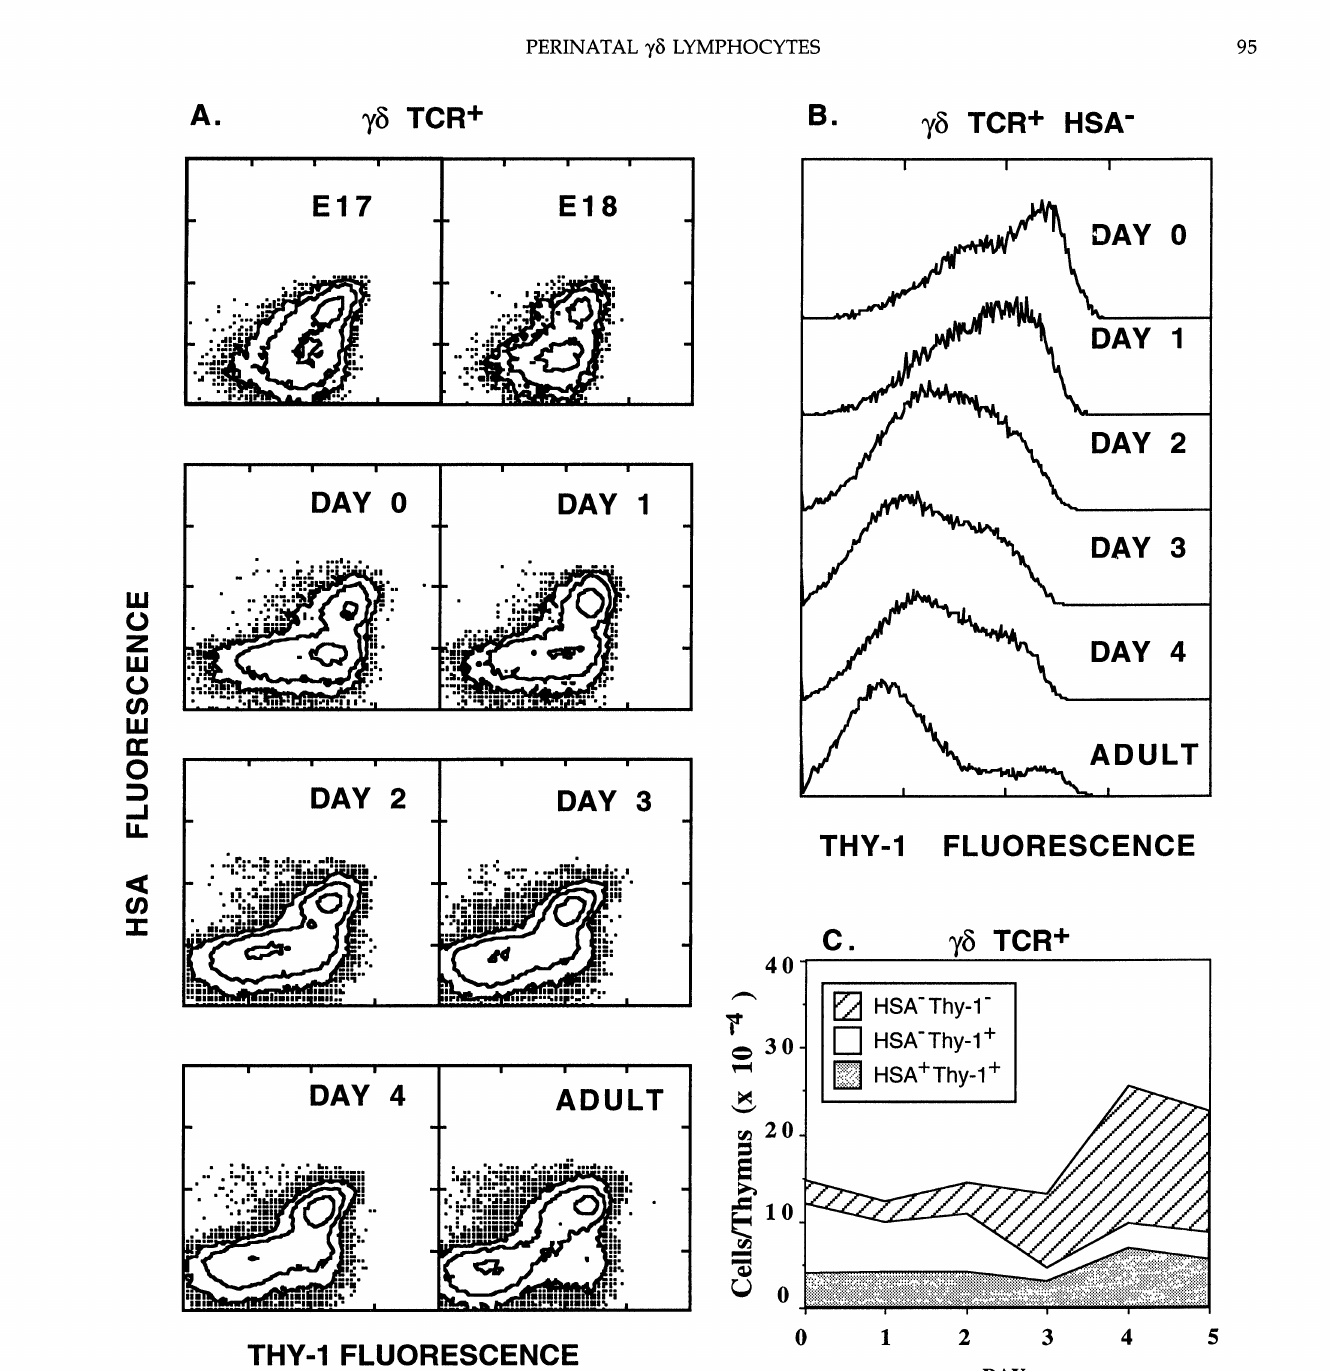
FIGURE 2. The perinatal 73 populations in the thymus. Flow cytometric analysis was performed on CD4- CD8-cells isolated from the thymuses of 6 to 20 mice, depending on the age of the mice and thymus size. The data shown are representative of three experiments. (A) Contour plots of the HSA and Thy-1 fluorescence of total 73 T thymocytes from mice at E17 to 4 days after birth. The populations begin to resemble the adult distribution by day 4 and are identical by 2 weeks (data not shown). (B) In order to clearly identify the changes in the Thy-1 expression over this time period, the files shown in the contour plots were electronically gated HSA- and 73 TCR The histograms show the Thy-1 expression on all the HSA- cells and the shift in the level that occurs at days to 3 is apparent. (C) Graph of the actual numbers of cells present within each 73 T-cell subset during the first 5 days postnatal. Cell numbers are given on a linear scale and are represented by the differently shaded areas. Total 73 thymocytes are therefore the combined total of the three areas. The shift in Thy-1 expression that occurs at day 2 to 3 can been seen in the loss of HSA- Thy-1 cells and an increase of a similar number of cells in the HSA- Thy-1-